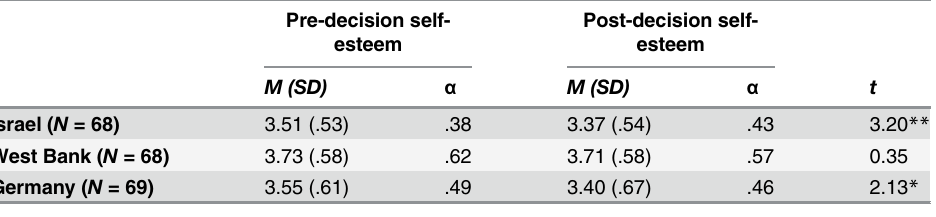
Table 1. Descriptive statistics for our questionnaire measure of self-esteem and pairwise t-test statis- tics for the difference in means between pre- and post-decision